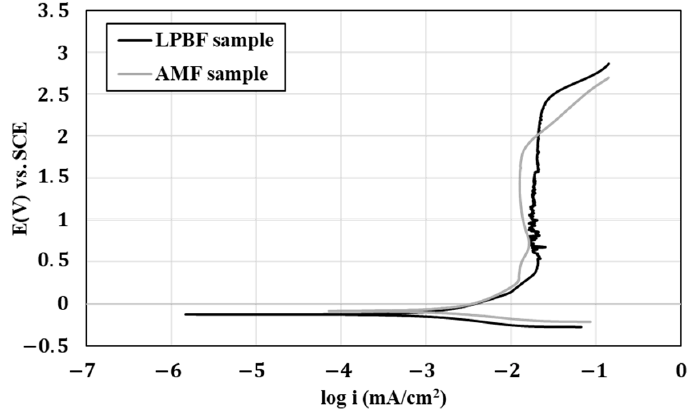
Figure 11. Potentiodynamic polarization analysis of HEA WTaMoNbV produced by LPBF versus its counterpart AMF alloy. Table 11. Electrochemical parameters derived from polarization curves shown in Figure 10 along with Tafel extrapolation for evaluating the corrosion rate.